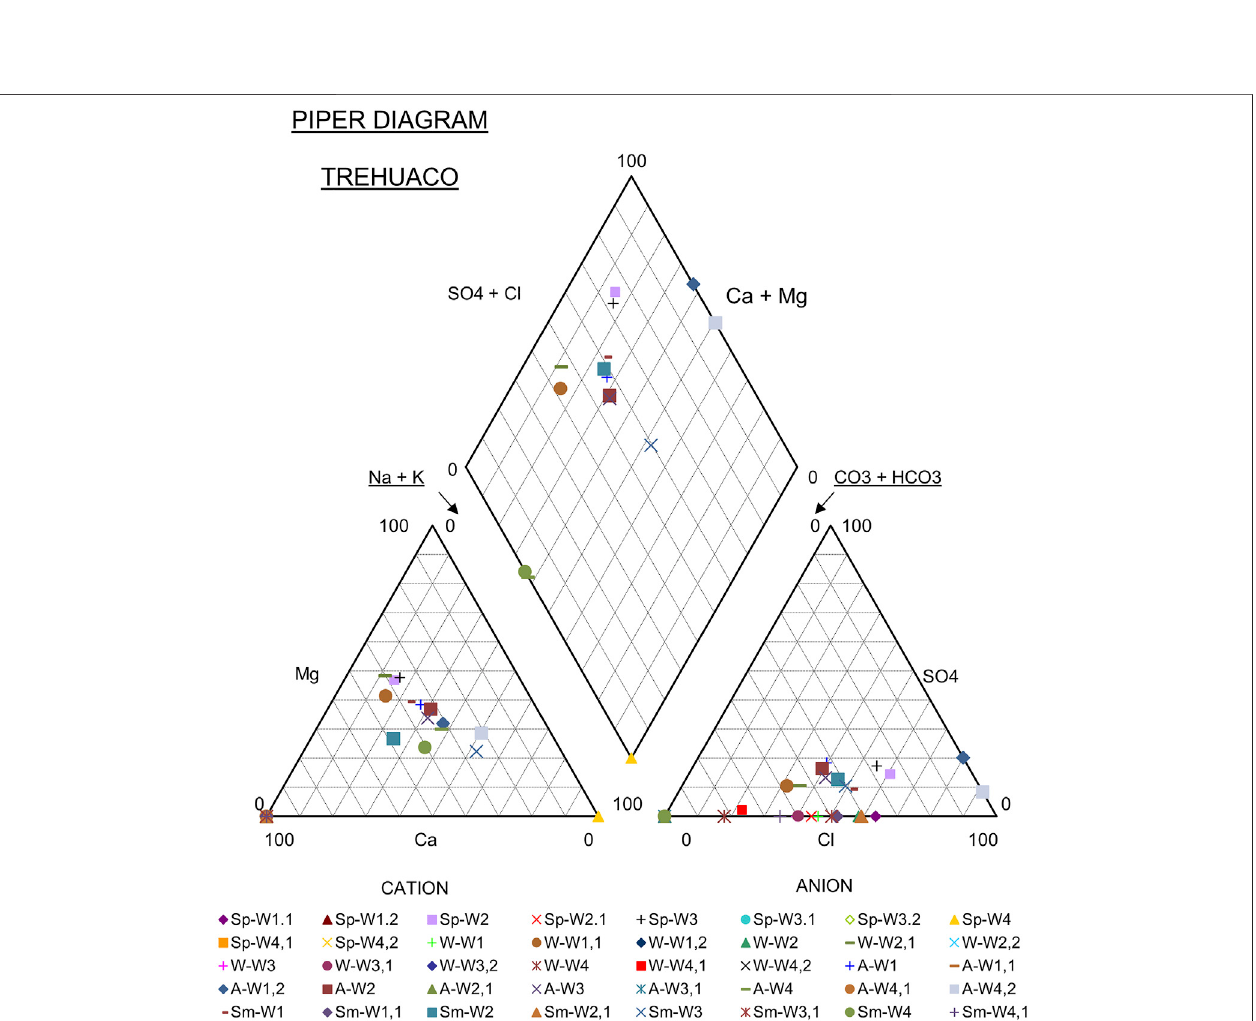
Frontiers in Environmental Science |